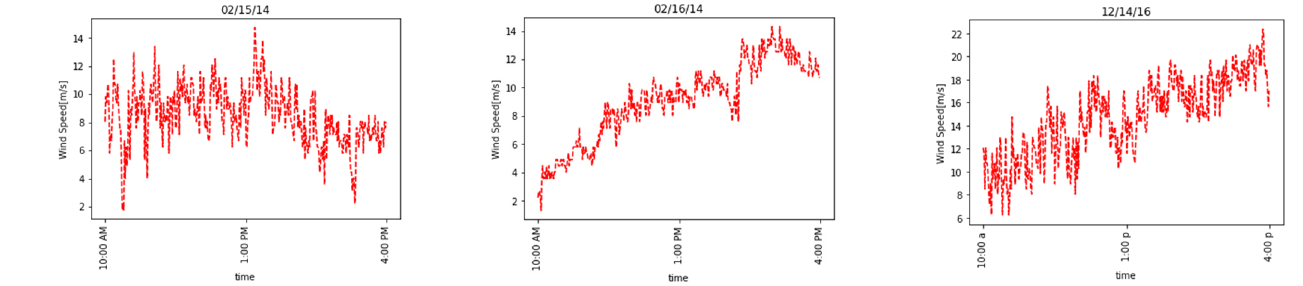
Figure 5. The vertical electric field ( top ) and wind speed results ( bottom ) for 3 events. 15 February 2014 ( left ), 16 February 2014 ( middle ) and 14 December 2016 ( right ). High values were recorded during short periods of light rain.